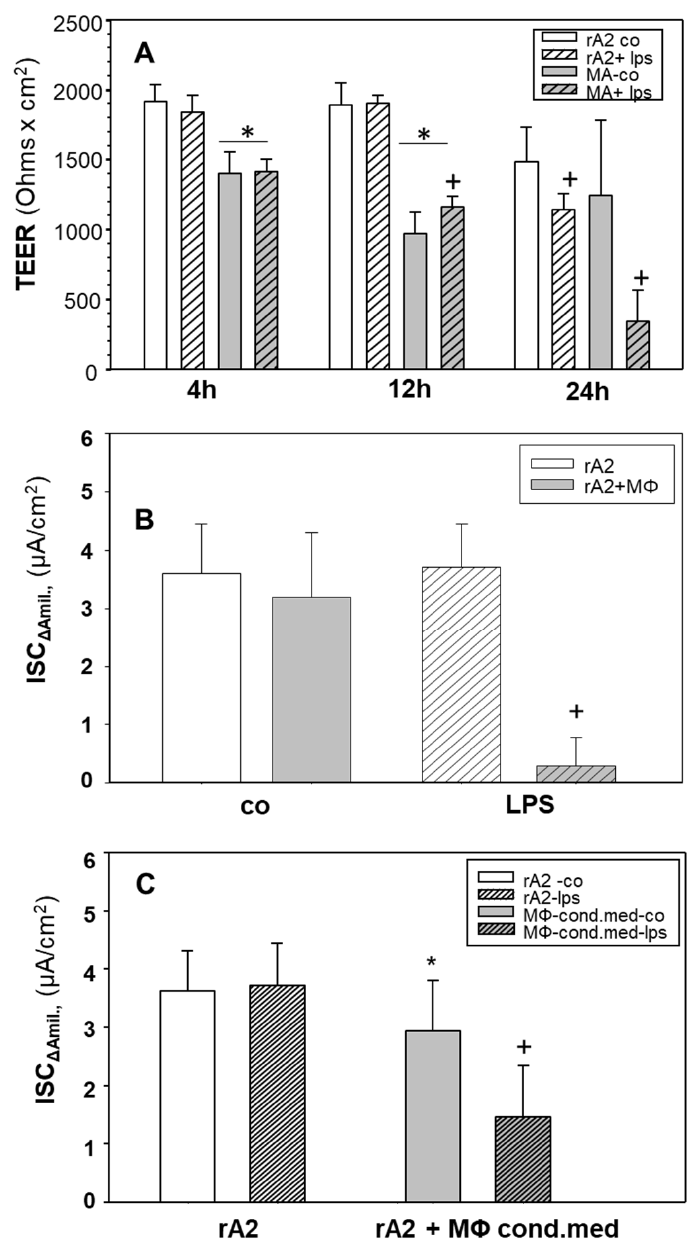
Figure 1. Effects of LPS on the transepithelial resistance and ion transport of rA2 cells in mono- and co-culture with alveolar macrophages and of conditioned medium obtained from LPS stimulated macrophages. Mono and co-cultures of rA2 cells with alveolar macrophages were prepared as described in the Methods section and treated with LPS (1 µ g/mL) at indicated time points. Transep- ithelial electrical resistance (TEER) was measured by EVOM (Ohms × cm 2 ) ( A ). Short circuit currents were measured in Ussing chambers in mono and co-cultures treated with LPS (1 µ g/mL) for 24 h ( B ). Conditioned macrophage media was prepared by exposing mono-cultures of macrophages to LPS (1 µ g/mL) for 24 h and kept on rA2 monolayers for 24 h. ENaC activity was measured as the amiloride (10 µ M) sensitive component of I eq in Ussing chambers (ISC ∆ amil ). ( C ). Mean values ± SD of 5–11 experiments from at least 3 independent preparations of primary rA2 cells. * p < 0.001 effect of culturing macrophages or conditioned media with rA2 cells, + p < 0.001 effect of LPS treatment compared to relevant controls. M Φ : rat alveolar macrophages; rA2: rat alveolar epithelial cells alone; rA2 co: control rat alveolar epithelial cells that did not receive M Φ , M Φ conditioned medium or LPS; MA: M Φ and rA2